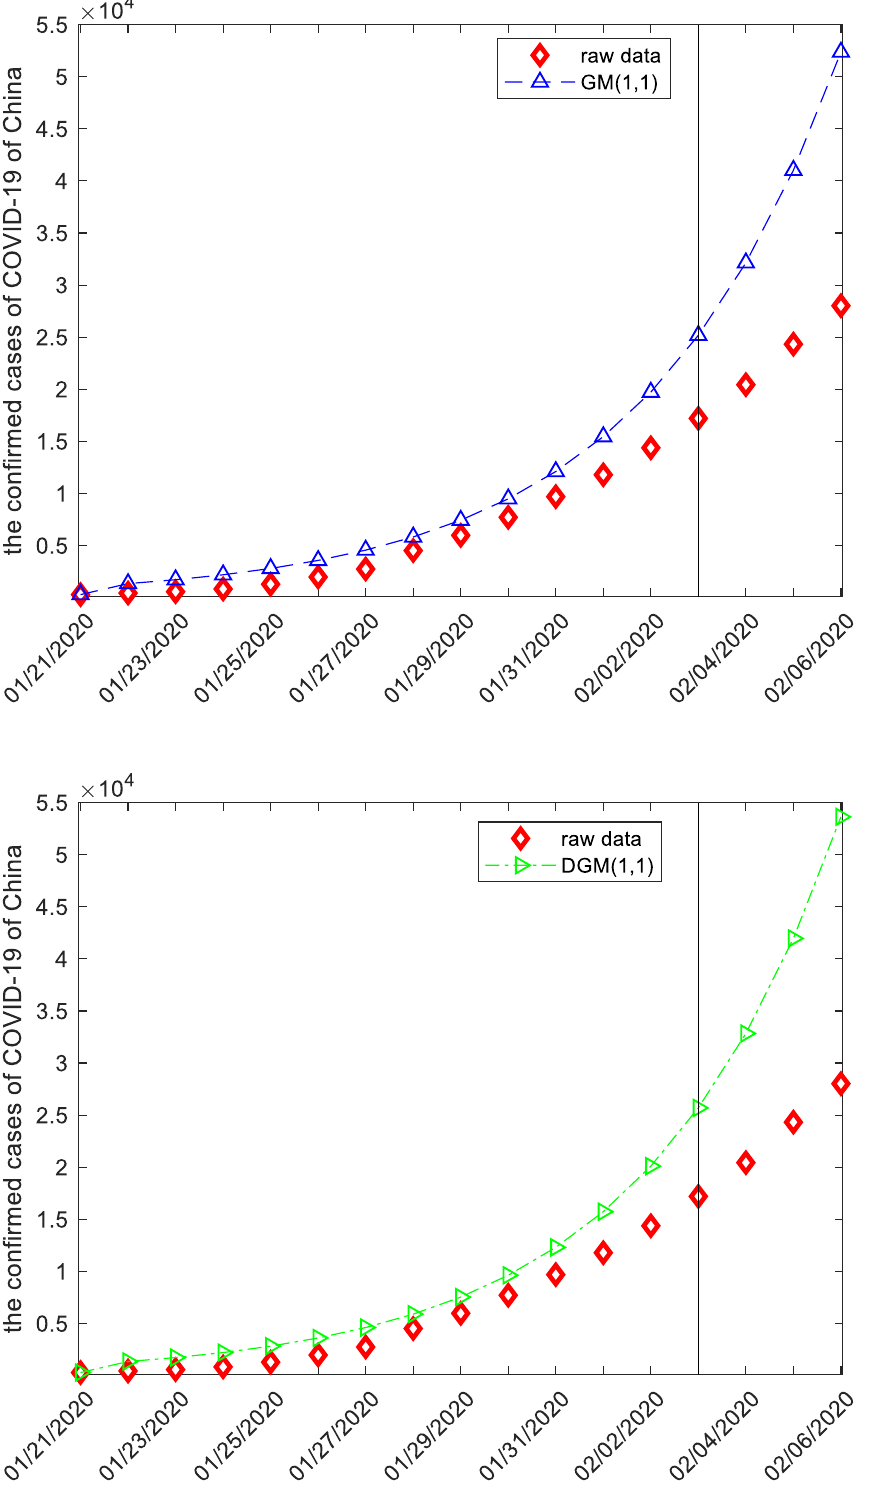
Figure 4. The plots of the confirmed cases of COVID-19 of